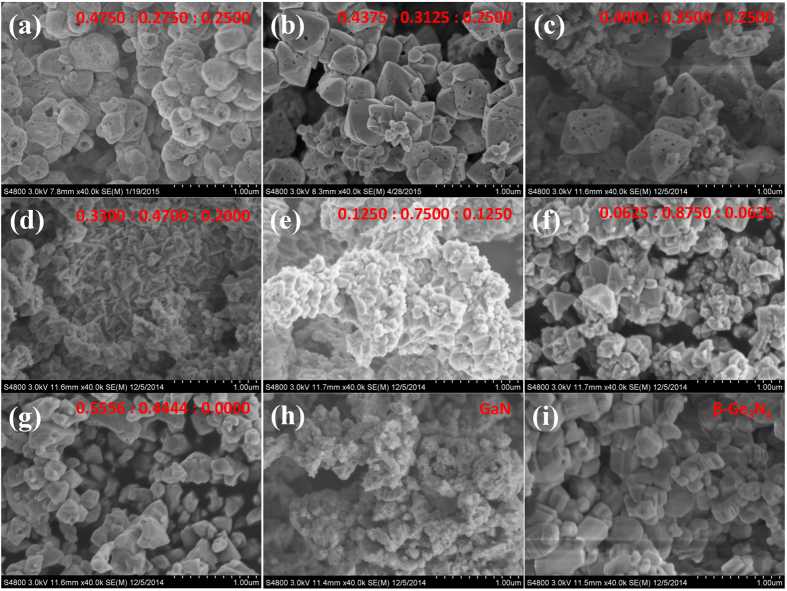
Field emission scanning electron microscopy images of samples prepared from different starting Zn/Ga/Ge molar ratios: (a) 0.4750: 0.2750: 0.2500, (b) 0.4375: 0.3125: 0.2500, (c) 0.4000: 0.3500: 0.2500, (d) 0.3300: 0.4700: 0.2000, (e) 0.1250: 0.7500: 0.1250, (f) 0.0625: 0.8750: 0.0625, (g) 0.5556: 0.4444: 0.0000, (h) 0.0000: 1.0000: 0.0000, i.e. GaN and (i) 0.0000: 0.0000: 1.0000, i.e. Ge3N4. Ammonolysis conditions were all kept the same at 900 °C for 5 hours with ammonia flow rate ~250 ml/min.